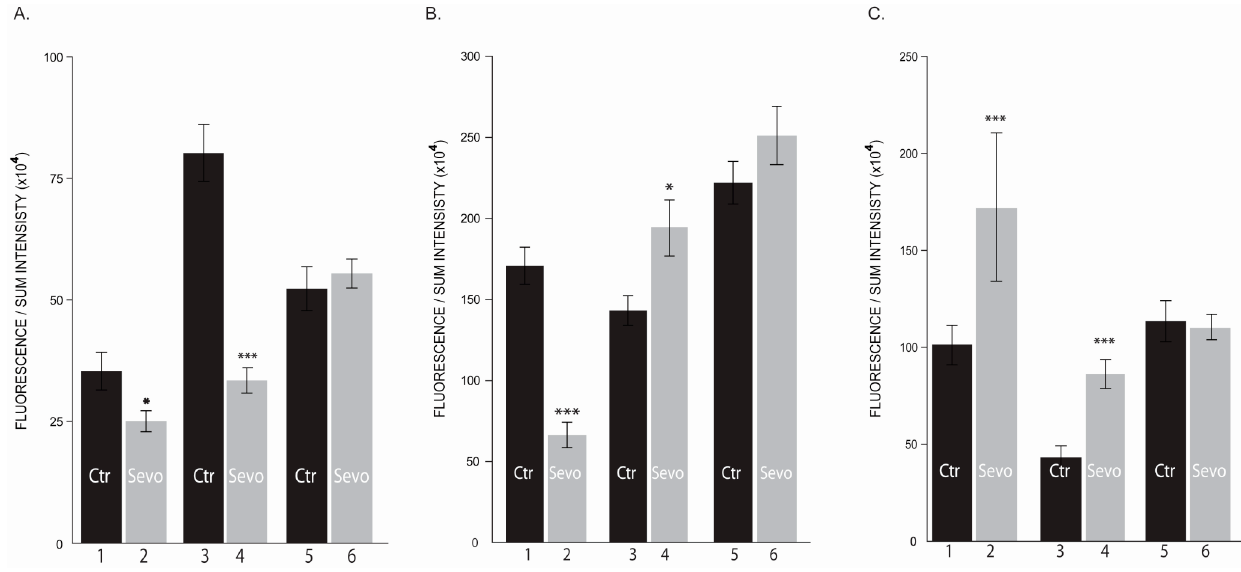
Figure 5. Level of AKT isoforms in MDA-MB231. ( A ) AKT1 expression level; ( B ) AKT2 expression level; ( C ) AKT3 expression level (1, 2–6 h; 3, 4–24 h; 5, 6–72 h; Ctr-untreated cells; sevo-treated cells with 2 mM sevoflurane; h-hours) * p < 0.05; *** p < 0.0005. n = 2.